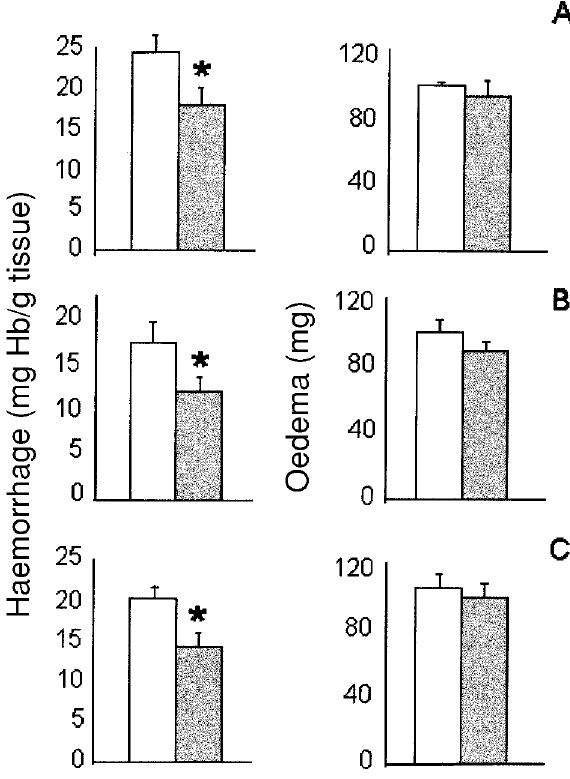
FIG. 5. Effect of treatments with (A) capsaicin, (B) guanethi- dine and (C) surgical denervation on B. jararaca -induced haemorrhage and oedema. Mice were treated with (A) capsaicin (50mg/kg,s.c., on the 2nd day after the birth), (B) guanethidine (3 doses of 30mg/kg, with 24h intervals, lasting 24h before the venom) or (C) surgical denervation by sciatic and saphenous nerve section, 7 days before the venom injection. Animals received 5 m g of B. jararaca venom into the foot pad. Haemorrhage and oedema in treated animals (dark bars) were compared with results obtained in saline treated control groups (white bars). Mean ± SE. * p <